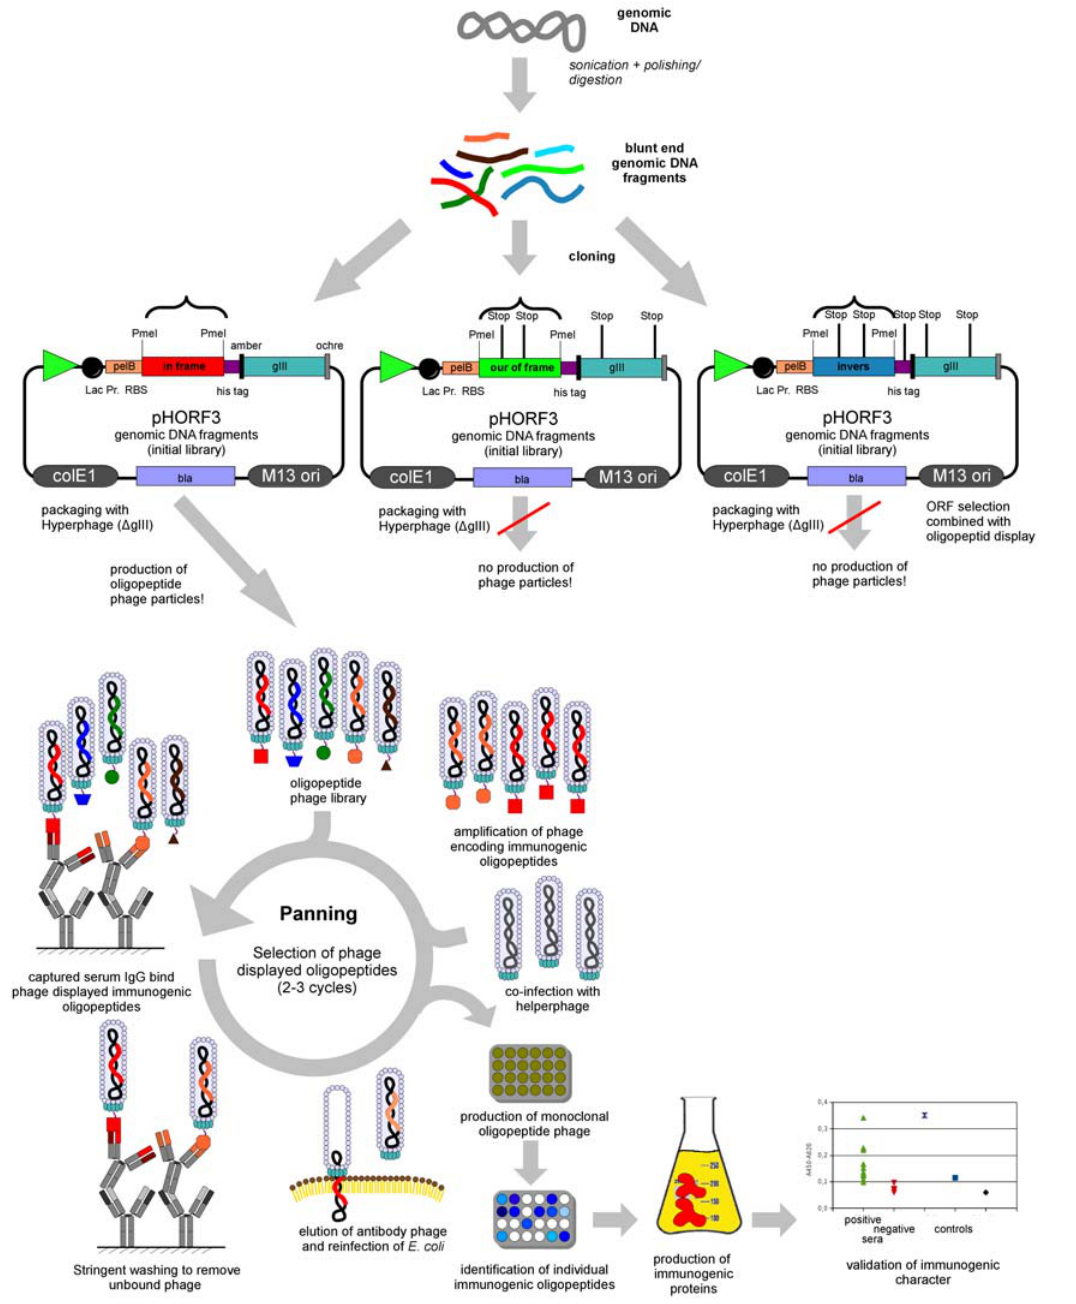
Figure 2. Schematic overview of library construction, ORF selection, panning on captured serum antibodies and validation of the immunogenic character (modified from